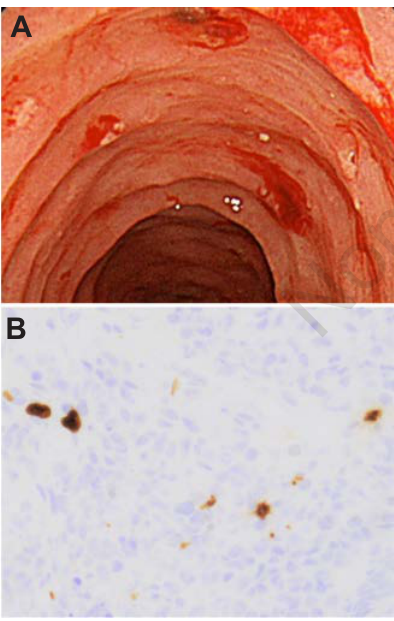
Figure 2. A) Endoscopic image demon- strating multiple mucosal hemorrhagic ulcers in the transverse colon. B) Immunohistochemistry of the biopsy spec- imen shows its positivity to CMV antigen, demonstrated using a monoclonal anti- body